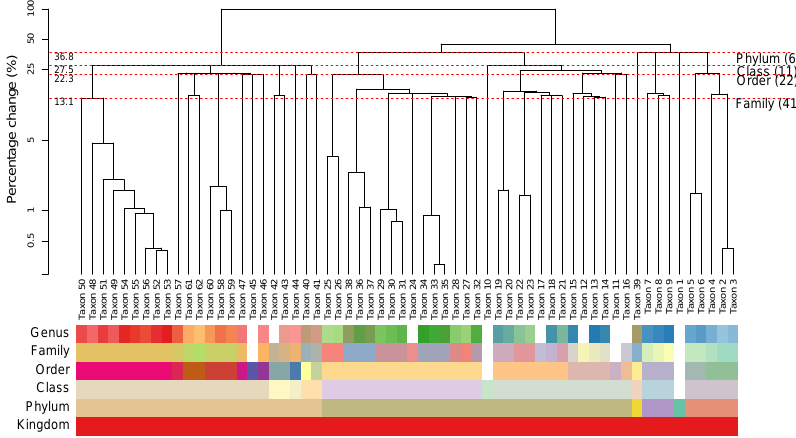
Figure 3. The NICU data: Dendrogram of HPAA with SDI and strong taxonomic